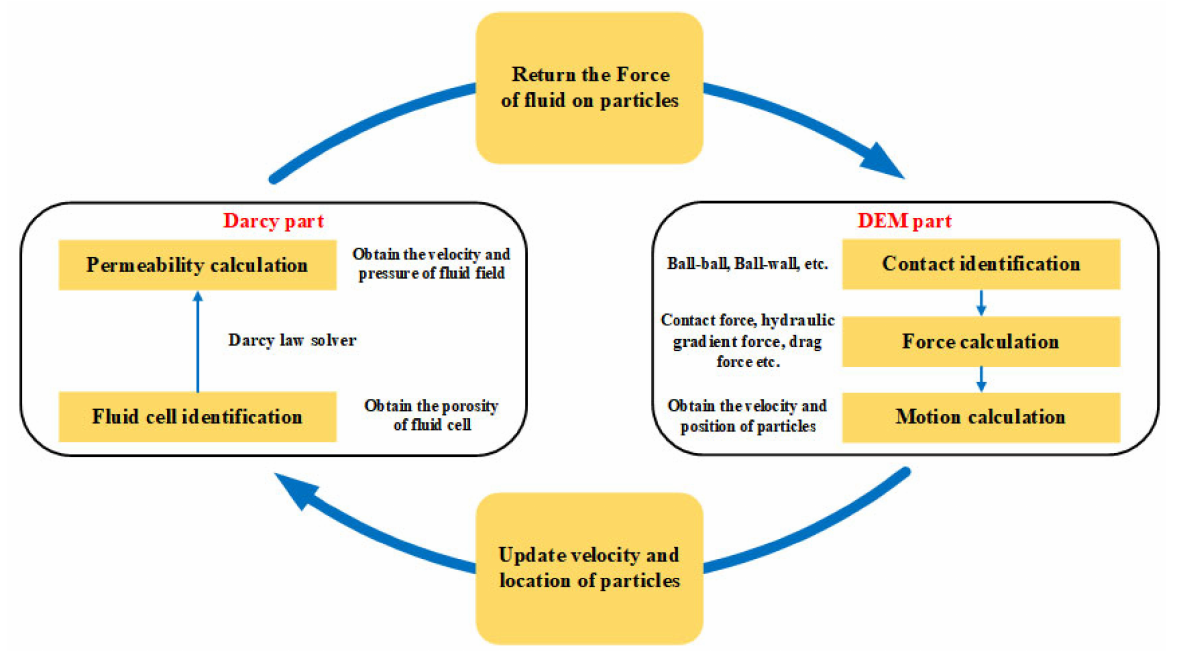
Figure 1. Computational procedure of DEM-Darcy